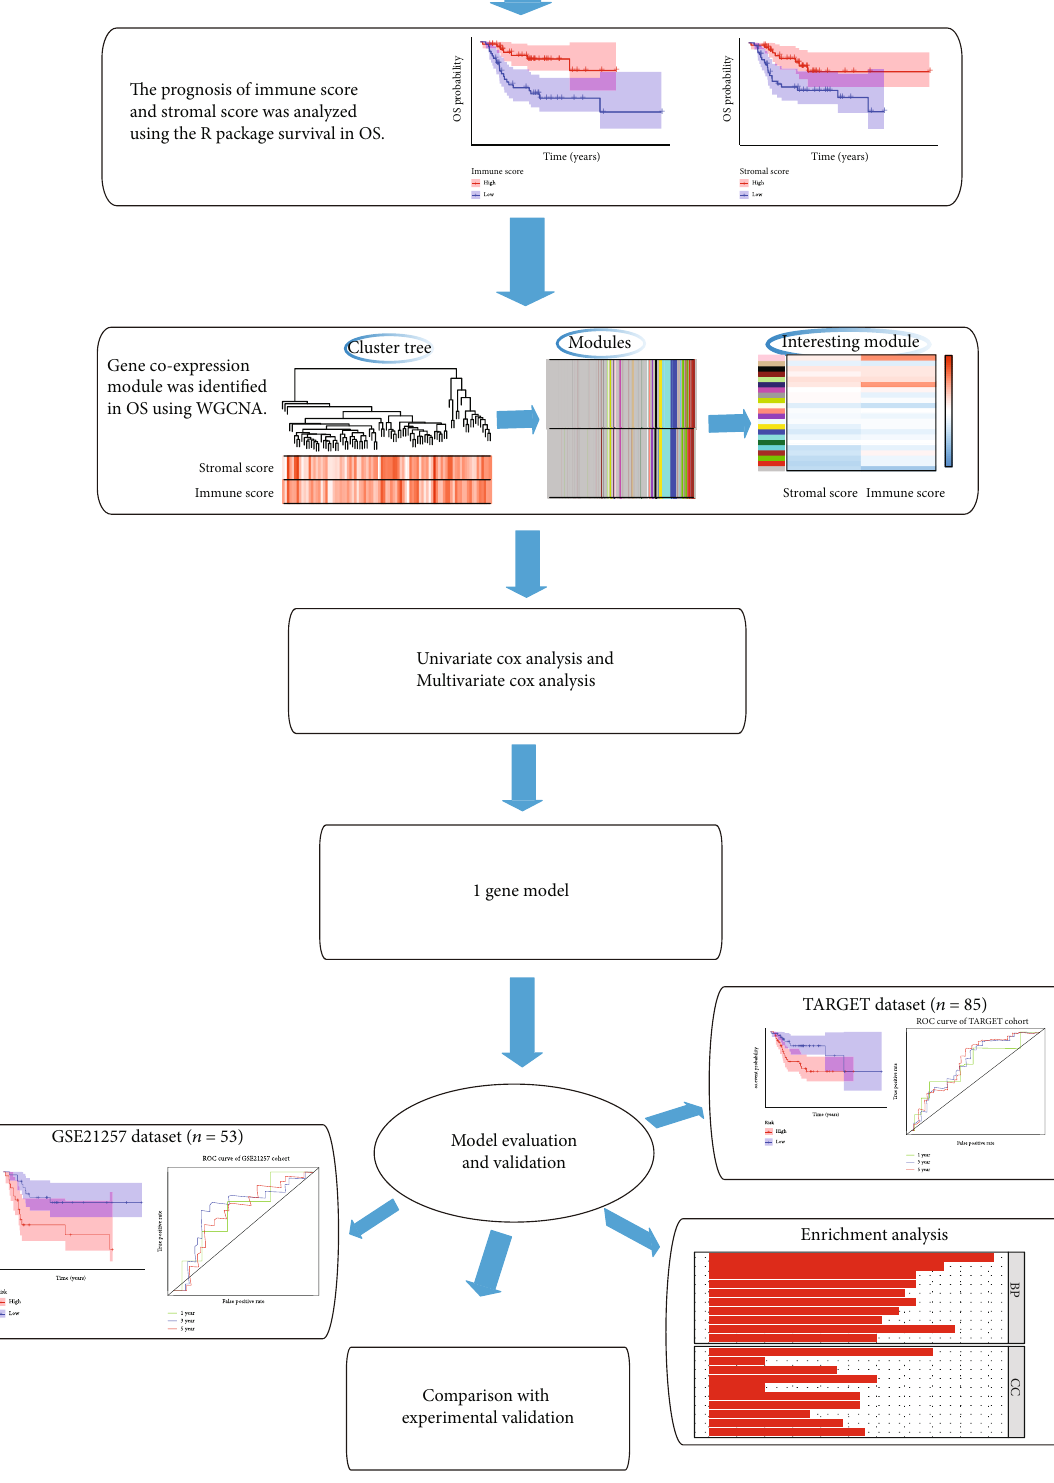
Figure 1: Flowchart of the present